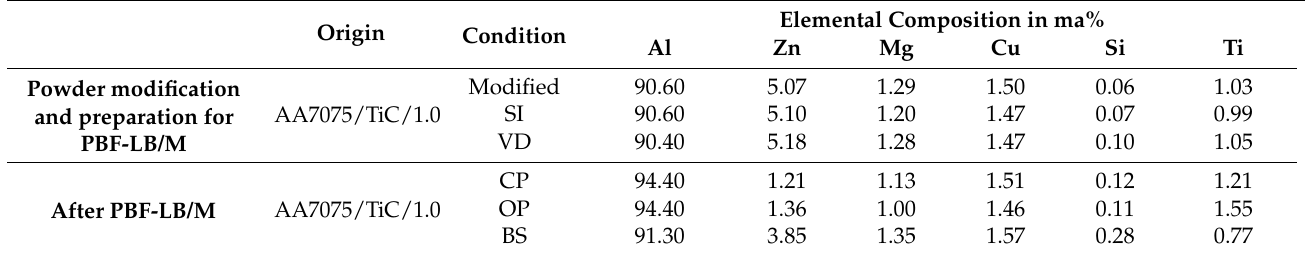
Table 3. Elemental composition for powder, powder derivate, and part manufactured by PBF-LB/M determined by energy-dispersive X-ray